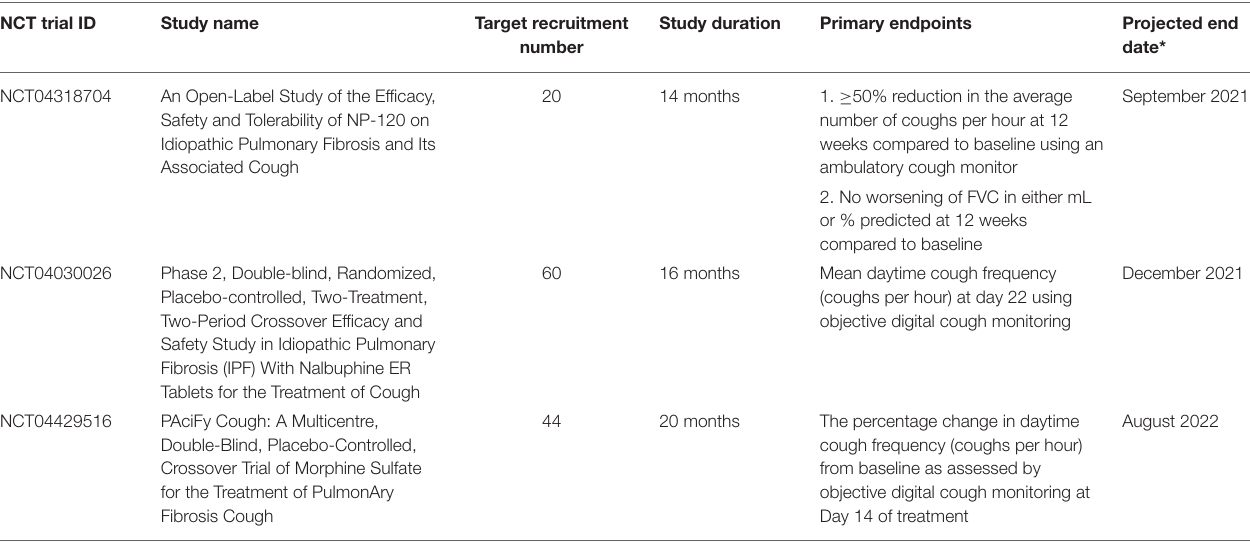
TABLE 4 | Clinical trials under recruitment for cough in